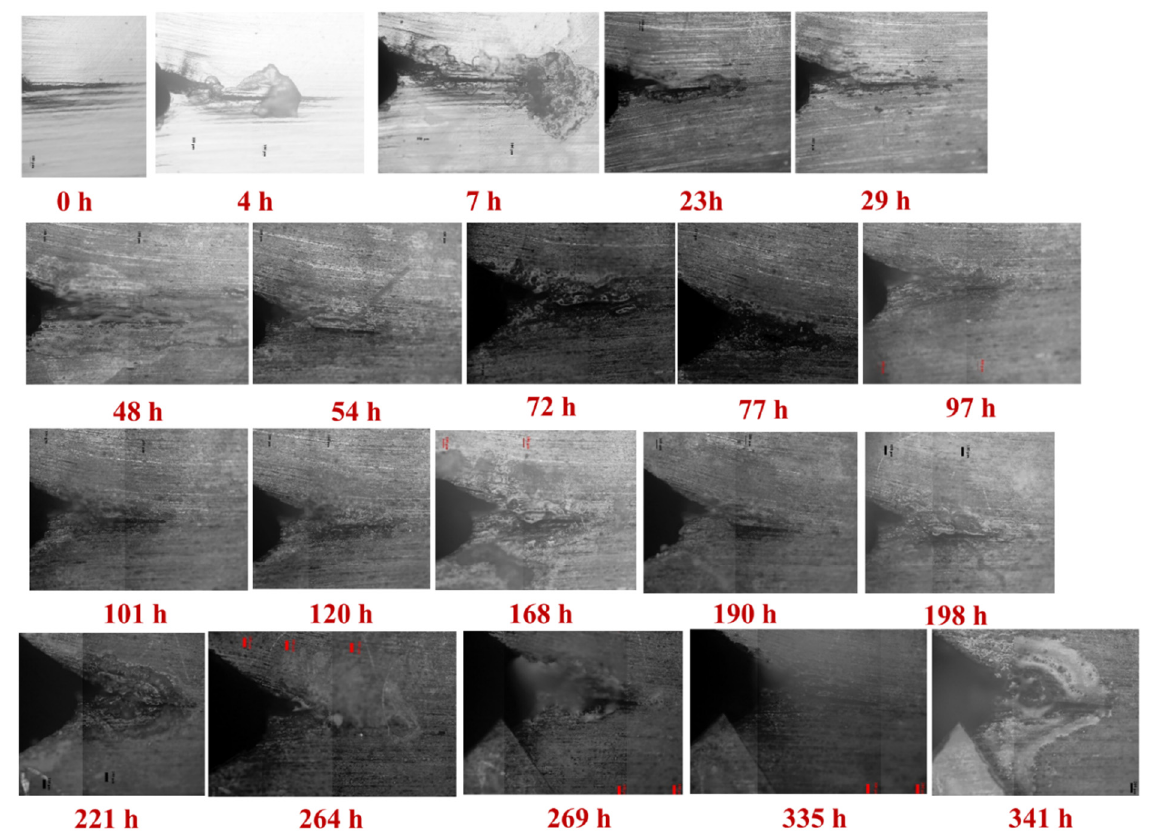
Figure 3. The crack propagations in the B ‐ plane of the pre ‐ cracked self ‐ stressed DCB specimen, characterized by OM.